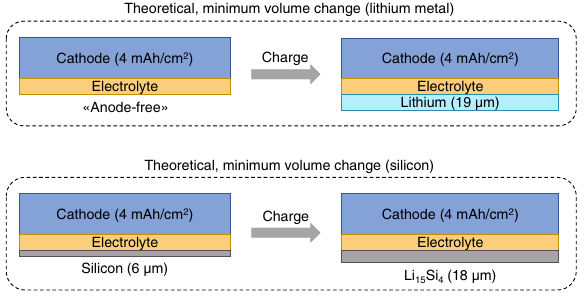
Fig. 4 | Theoreticalvolumetric changesuponcell charge of lithium metal(top) and silicon-based (bottom) cells. Volume change is visualized as a change in one dimension, namely thickness. In general, materials can expand in all three dimen- sions.Thetoppanelshowsthatthedepositionof4mAh/cm 2 oflithiummetalwould lead to an increase in cell thickness of about 19 µ m per negative electrode layer, based on a speci fi c capacity of 3860mAh/g and a density of 0.53g/cm 3 , i.e., a volumetric capacity of 2045mAh/cm 3 . The bottom panel shows that at the end of charge,thesameamountoflithium(i.e.,lithiumequivalents)inanalloyingreaction with silicon to form Li 15 Si 4 would lead to an increase in cell thickness per negative electrode layer of 12 µ m, and a comparable overall negative electrode thickness of 18 µ m.Adensityof2.33g/cm 3 wasusedforpuresiliconandavolumetriccapacityof 2194Ah/cm 3 forLi 15 Si 4 .Positiveelectrodeandelectrolytelayerareassumedtohave a constant thickness. Volumetric capacity and density determine cell energy den- sity, affecting how much space a cell would occupy, e.g., in a battery pack. Increasingcellenergydensitycanallow,forexample,moreelectrodelayersorcells to be integrated into the same